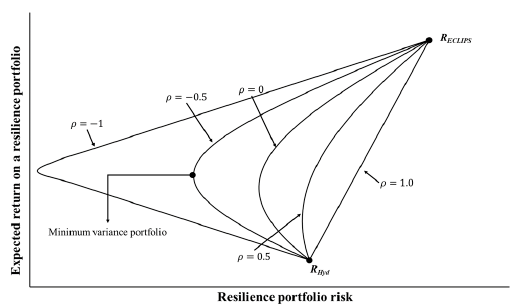
ffi cient frontier example with di ff erent covariance. Figure 2. Efficient frontier example with different covariance. Figure 2. E